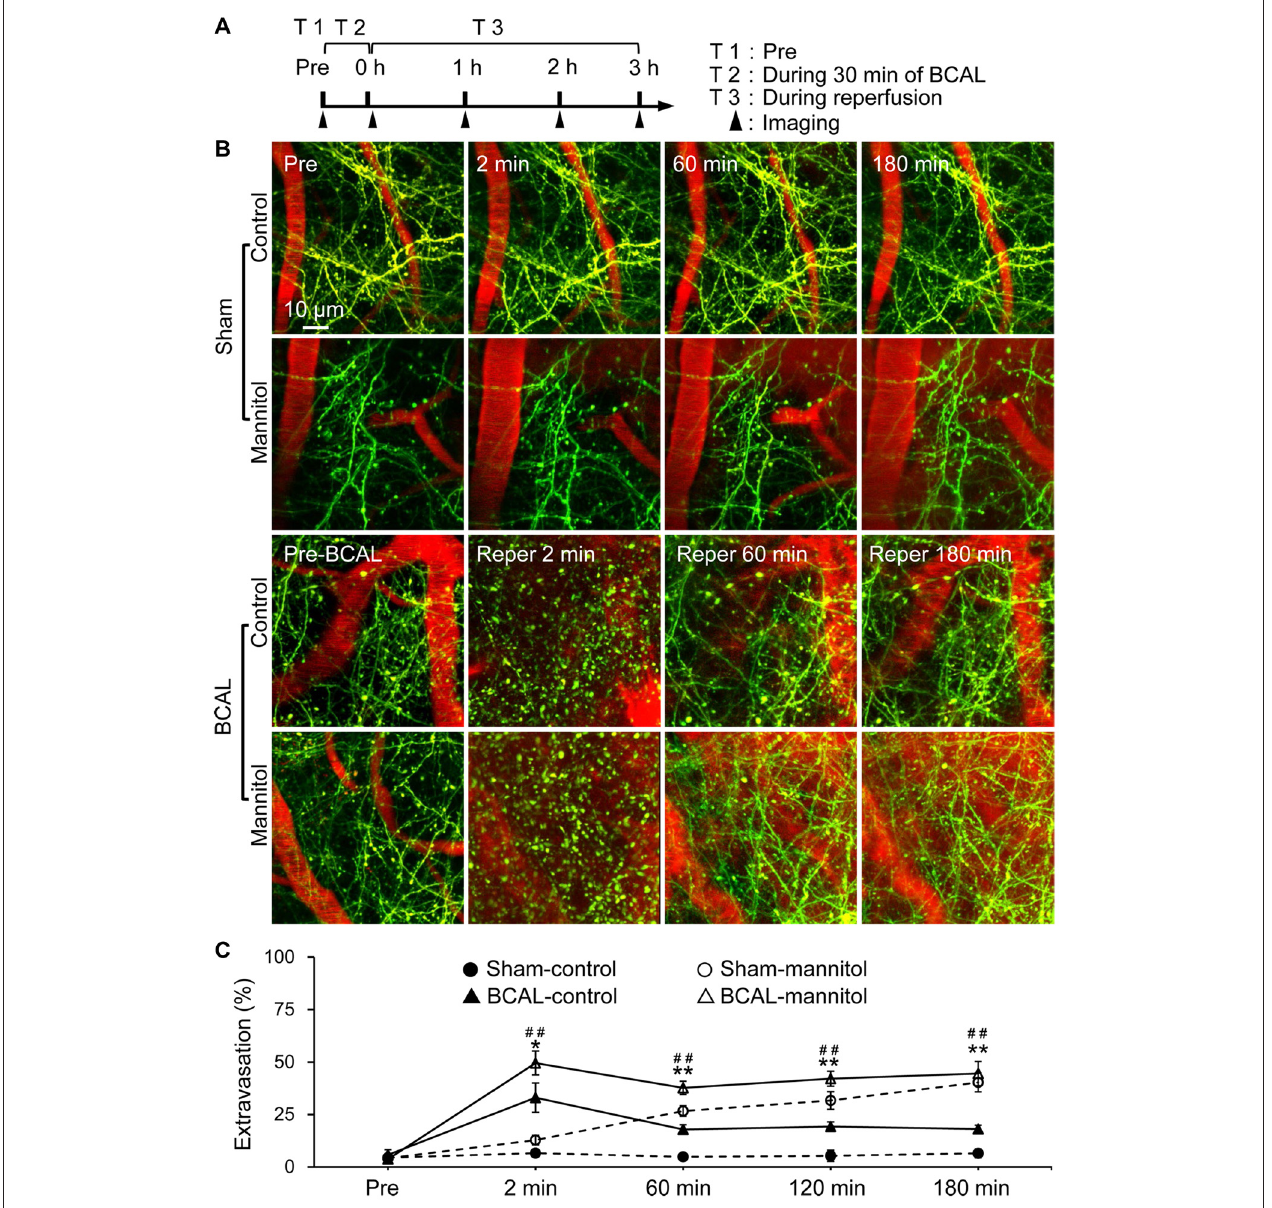
FIGURE 1 | Mannitol-induced change in blood-brain barrier (BBB) permeability after transient global cerebral ischemia. (A) Timeline shows time points for imaging during the transient ischemia-reperfusion model. Filled arrowheads show the imaging time points. (B) Two-photon images show Evans blue (EB) labeled extravasation (red) and dendritic structures (green) at pre, 2 min, 60 min and 180 min, respectively in sham-control mice, sham-mannitol mice, bilateral common carotid artery ligation (BCAL)-control mice and BCAL-mannitol mice. Note that beaded dendrites induced by transient ischemia restored following reperfusion in both BCAL-control mice and BCAL-mannitol mice. (C) Group data shows relative changes of extravasation at different time points ( n = 6 mice per group. Sham-control vs. Sham-mannitol ( ∗ ) ∗ p < 0.05 and ∗∗ p < 0.01; BCAL-control vs. BCAL-mannitol ( # ) ## p <